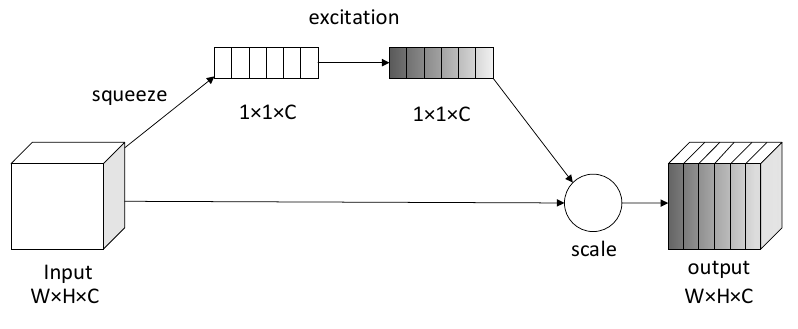
Figure 3. Schematic of SE block.